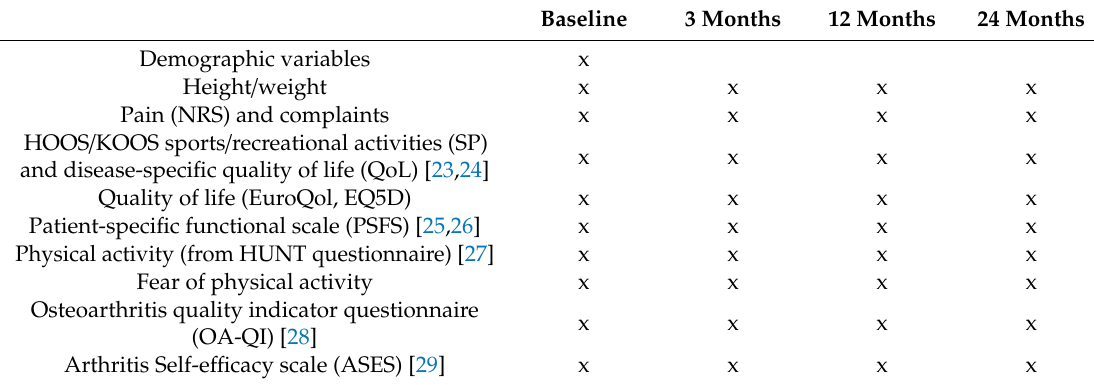
Table 1. Outcome measures included in the electronic registration at inclusion and 3-, 12- and 24-month